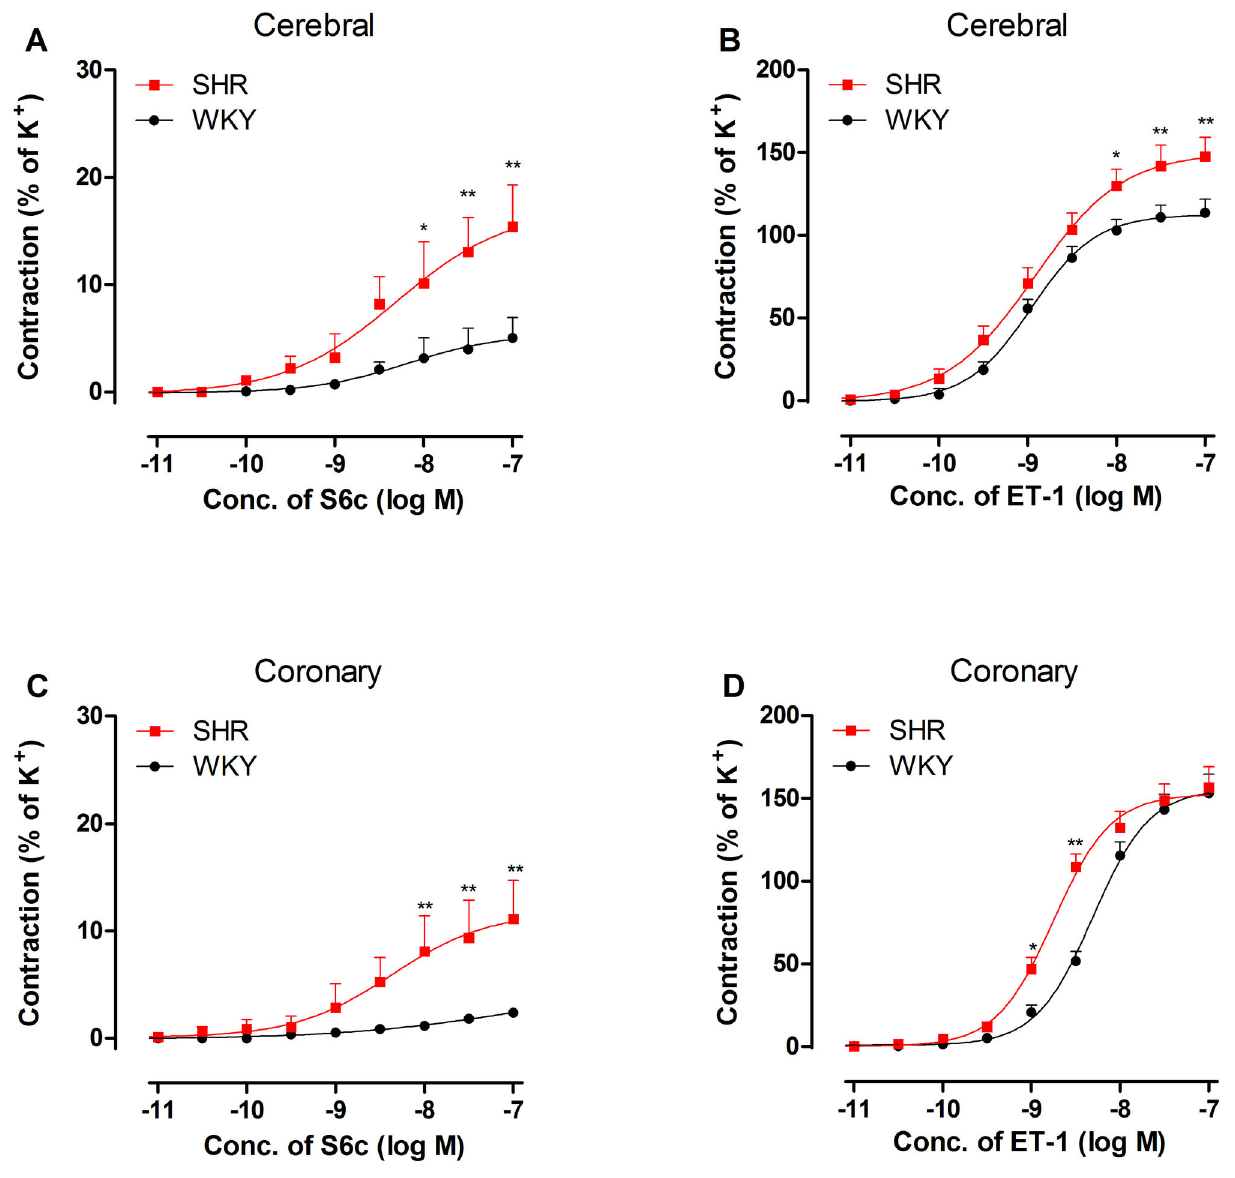
Figure 1. Concentration–response curves for cumulative sarafotoxin 6c (S6c, A and C) and endothelin-1 (ET-1, B and D) application in SHR and WKY cerebral (A, B) and coronary (C, D) arteries. Contractile responses were demonstrated as the percentage of K + -induced contraction. Each data point is derived from 10–14 animals and is expressed as the mean ± SEM. Statistical analysis was performed using a two-way ANOVA. * P <0.05, ** P <0.01 vs . WKY group. doi: